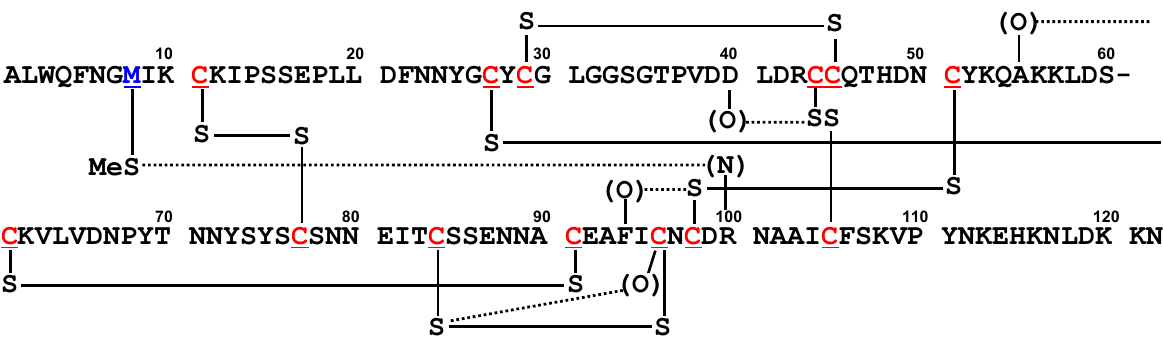
Figure 8. The amino acid sequence of bovine PLA